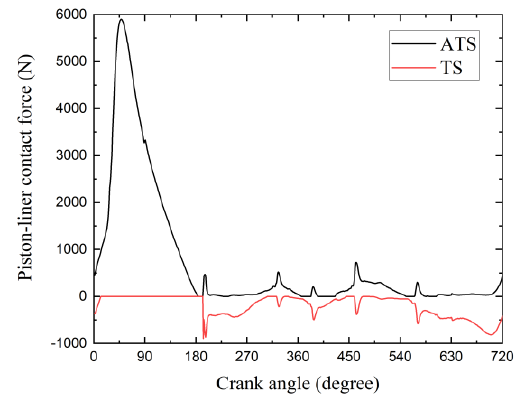
Figure 10. The load of cylinder 1# piston-liner contact force.